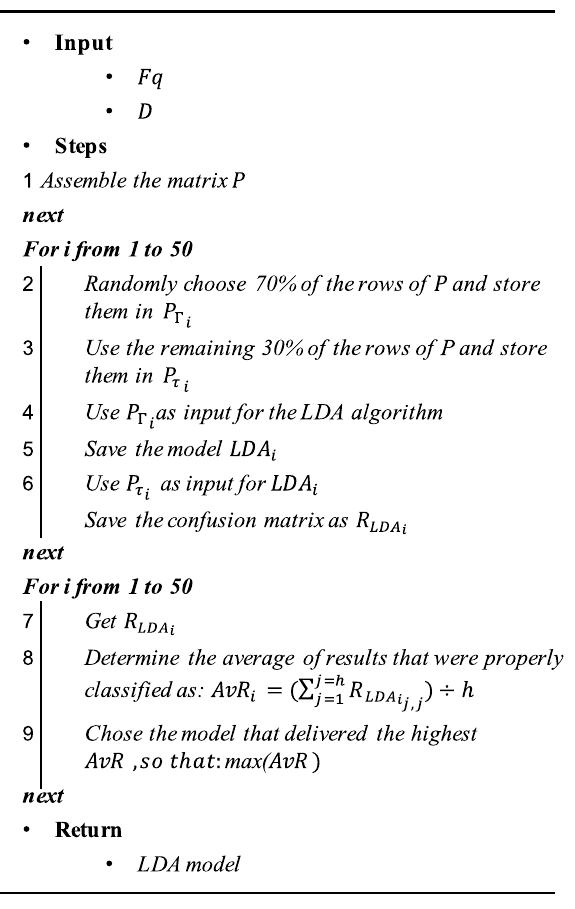
Figure 6. Pseudo-algorithm of the training process corresponding to step v.